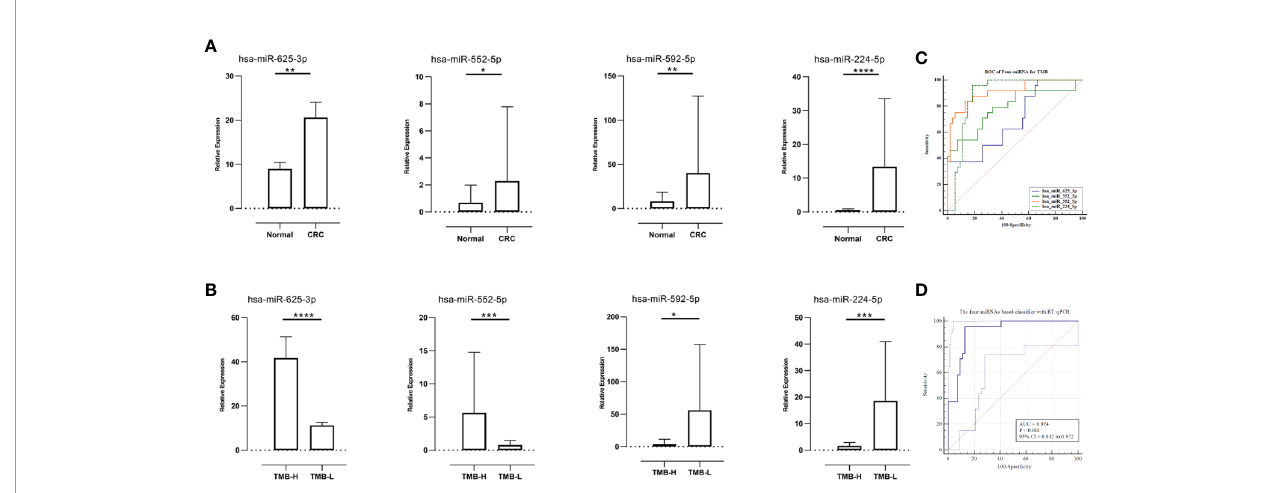
FIGURE 5 | Relative microRNAs (miRNAs) expression in diverse tissues and receiver operating characteristic (ROC) curves for the con fi rmation of miRNA-based signature index. (A) Relative miRNAs expression in paired samples (N = 27). (B) The relative miRNAs expression levels were compared between TMB-High CRC samples (N = 9) and TMB-Low CRC samples (N = 18). (C) The ROC curves of the single miRNA (qRT-PCR results of 27 samples). (D) The ROC curves of the four- miRNA (qRT-PCR results of 27 samples) in the model. * P < 0.05, ** P < 0.01, *** P < 0.001 and **** P <